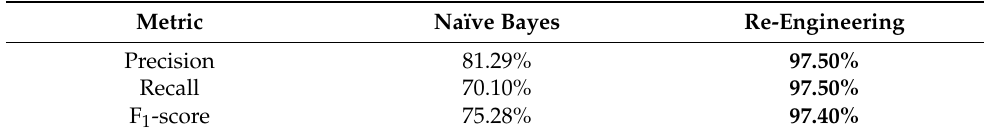
Table 1. Results comparison using the IMDB Dataset. The initial classification results using naïve Bayes classifier, as well as the results after applying the re-engineering mechanism. These results are averaged from 100 random tests. The boost of the performance has been found substantial.